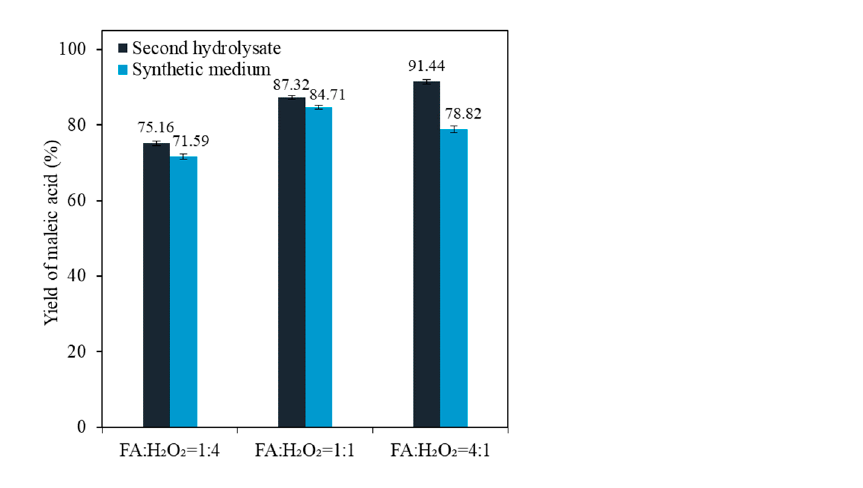
Figure 6. Maleic acid production from furfural in the second hydrolysate and synthetic medium, depending on the ratio of formic acid (FA) to H 2 O 2 .